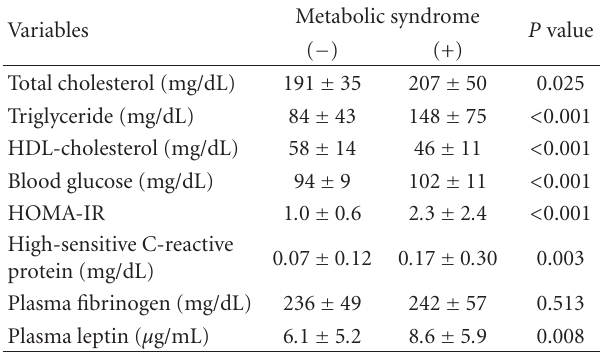
Table 3: Comparison of biochemical variables between essential hypertensives with and without metabolic